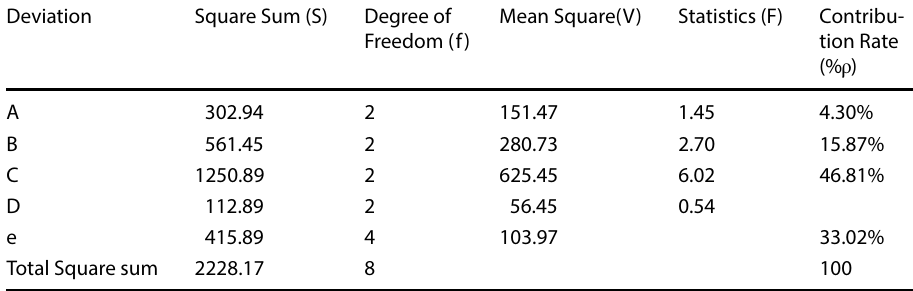
Table 5 The Variance Analysis of Experimental